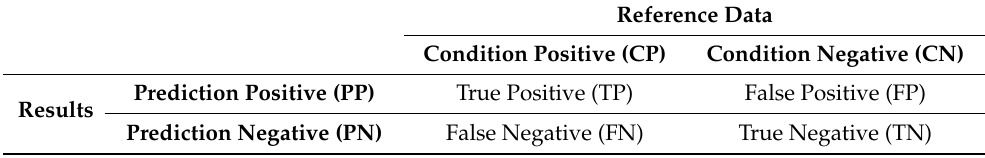
Table 2. Confusion